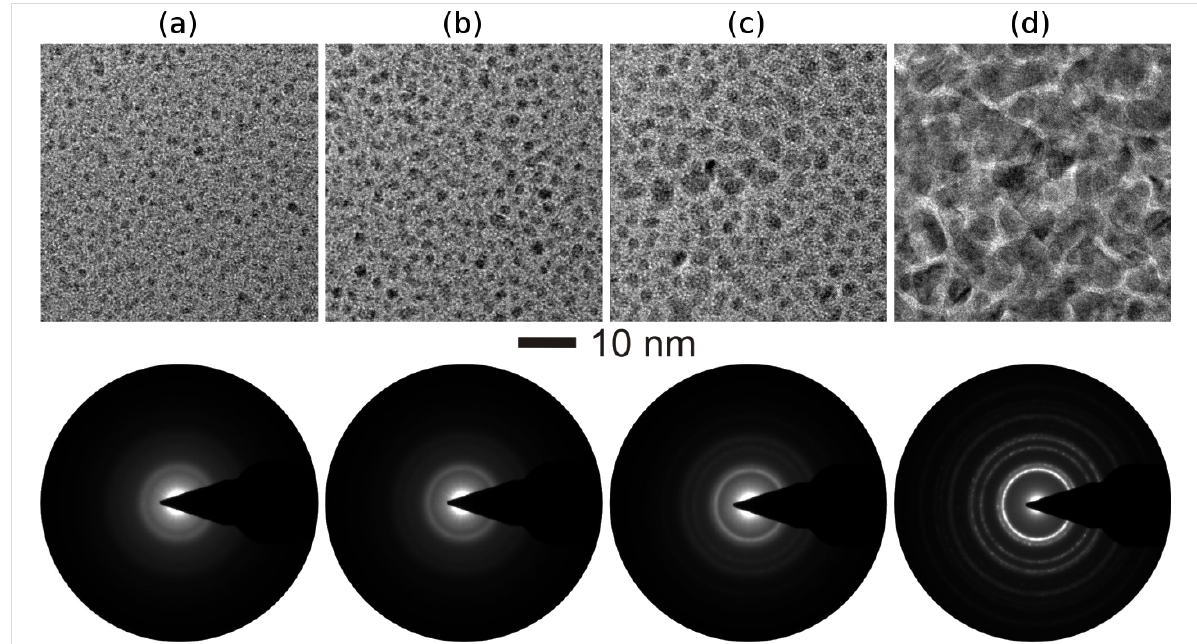
Figure 1: Bright-field TEM images of Au–TiO 2 nanocomposite thin films with different MVFs, (a) 7%, (b) 11%, (c) 13% and (d) 50%. In these bright- field TEM images, dark and bright areas correspond to the Au nanoparticles and the TiO 2 matrix, respectively. The selected area electron diffraction (SAED) patterns corresponding to each MVF composite is shown exactly below each TEM image.